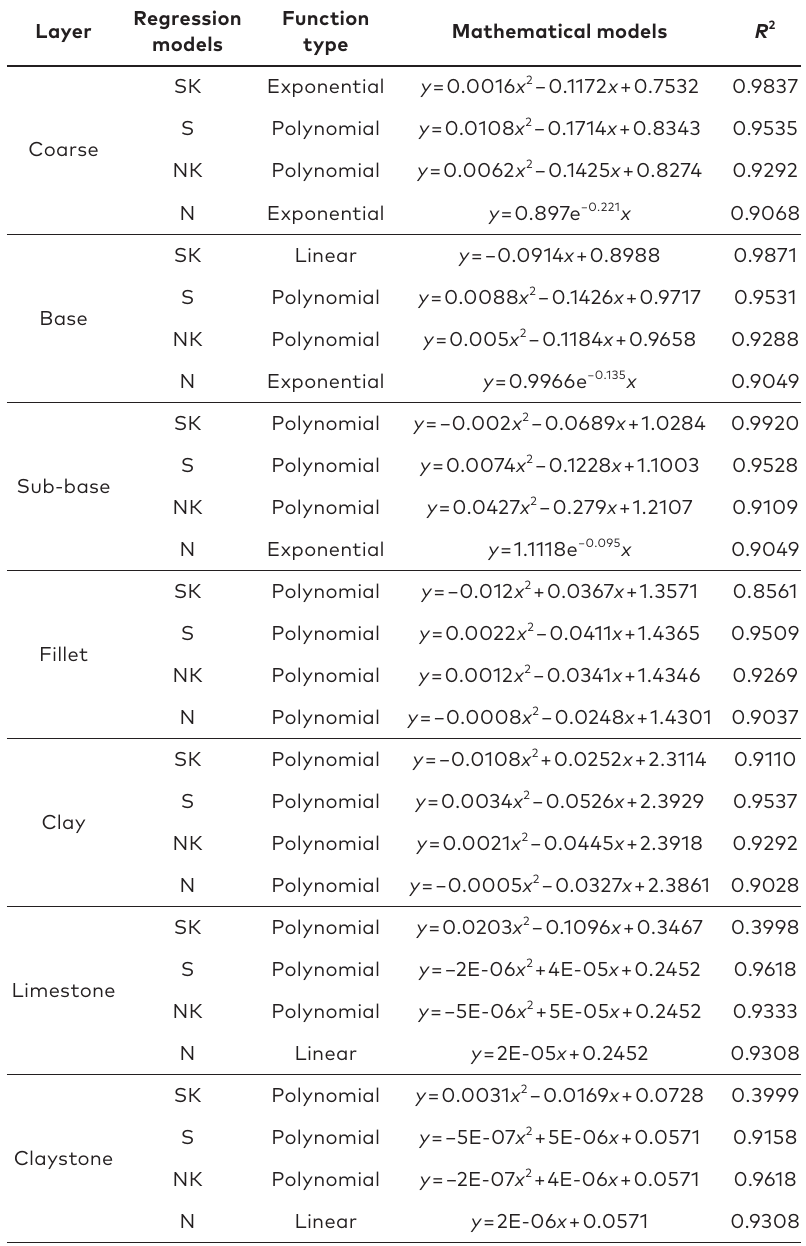
Table 13. Function and regression analyses of the relationship between the su- perstructure and soil layers of the road and lateral deformation ( Z )-Time